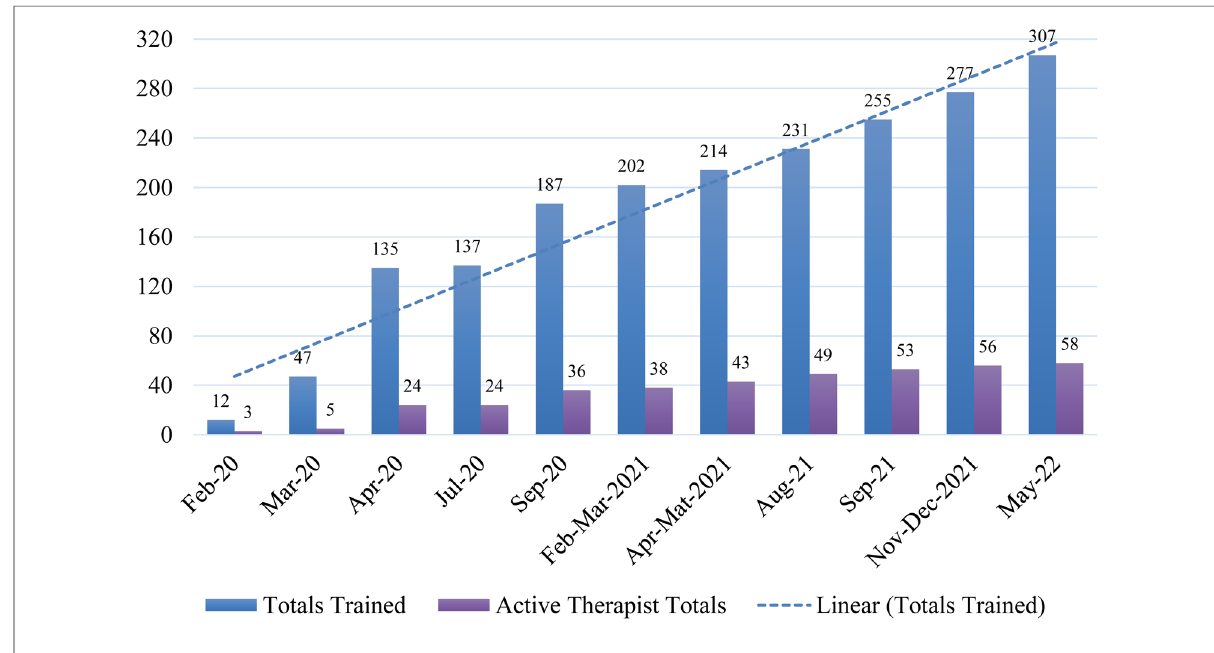
FIGURE 2 TOPS therapists trained and delivering the program from spring 2020 through spring